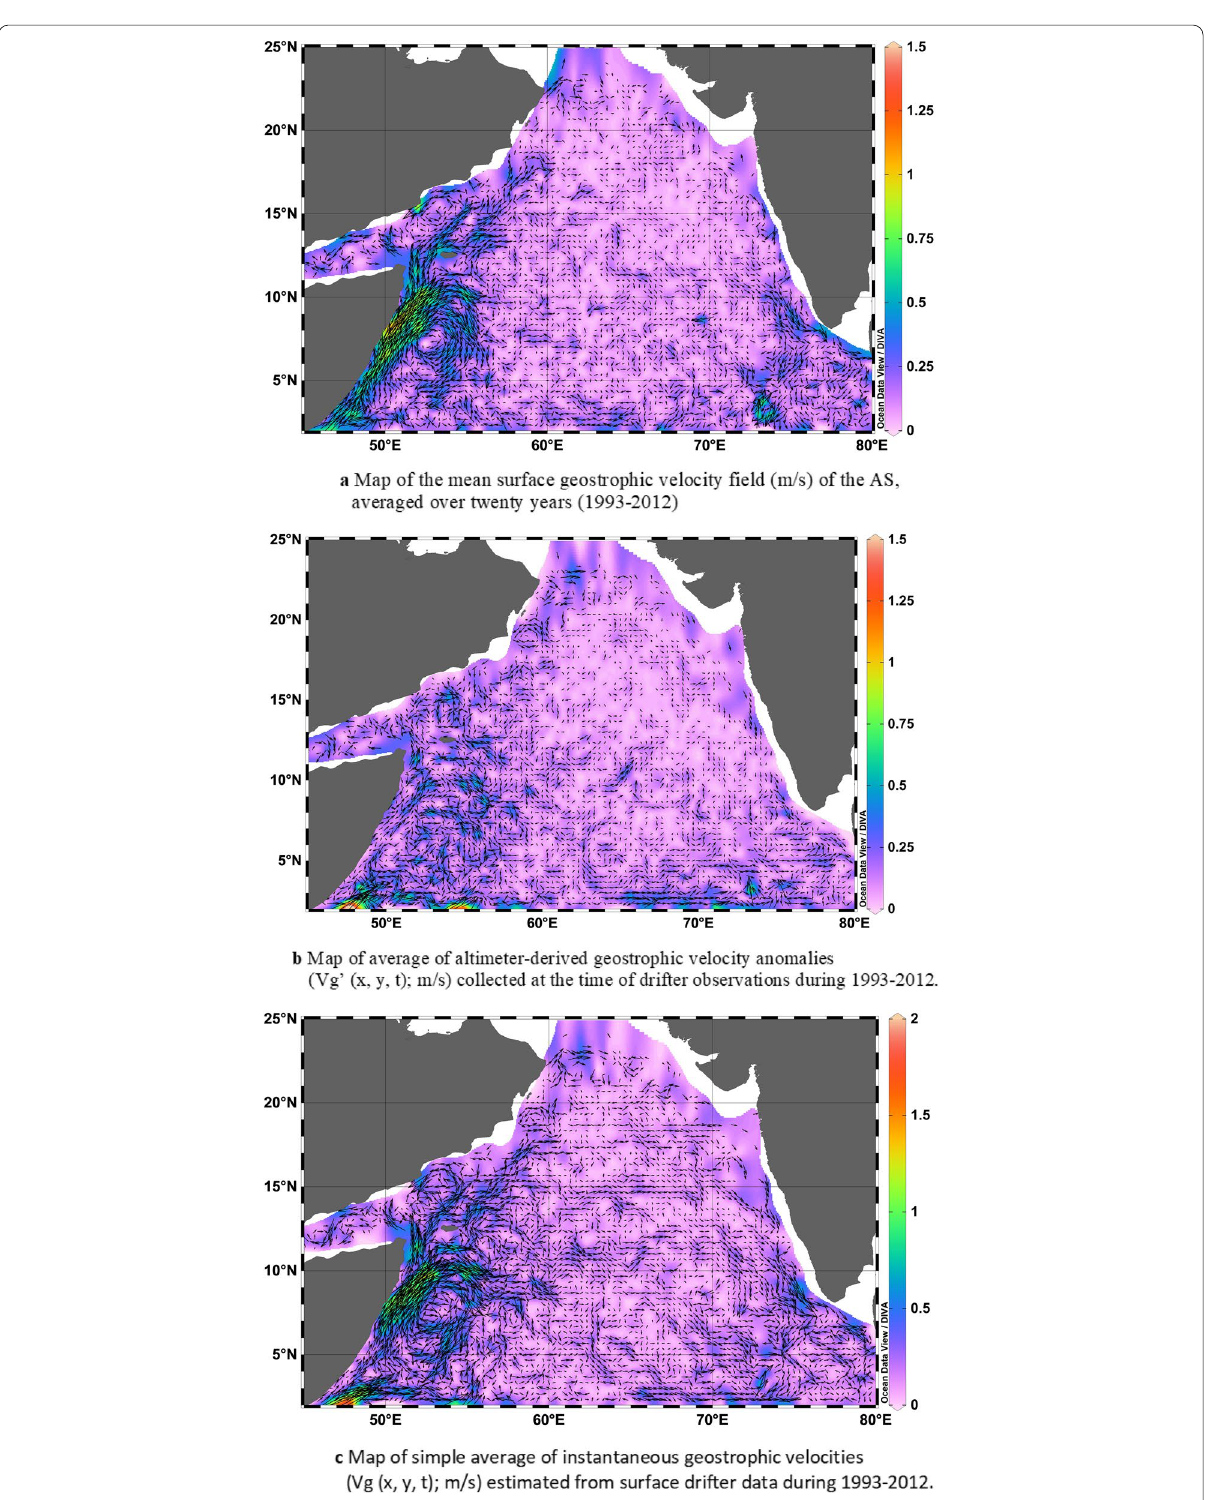
Fig. 4 a Map of the mean surface geostrophic velocity field (m/s) of the AS, averaged over twenty years (1993–2012). b Map of average of altimeter-derived geostrophic velocity anomalies (Vg’ (x, y, t); m/s) collected at the time of drifter observations during 1993–2012. c Map of simple average of instantaneous geostrophic velocities (Vg (x, y, t); m/s) estimated from surface drifter data during